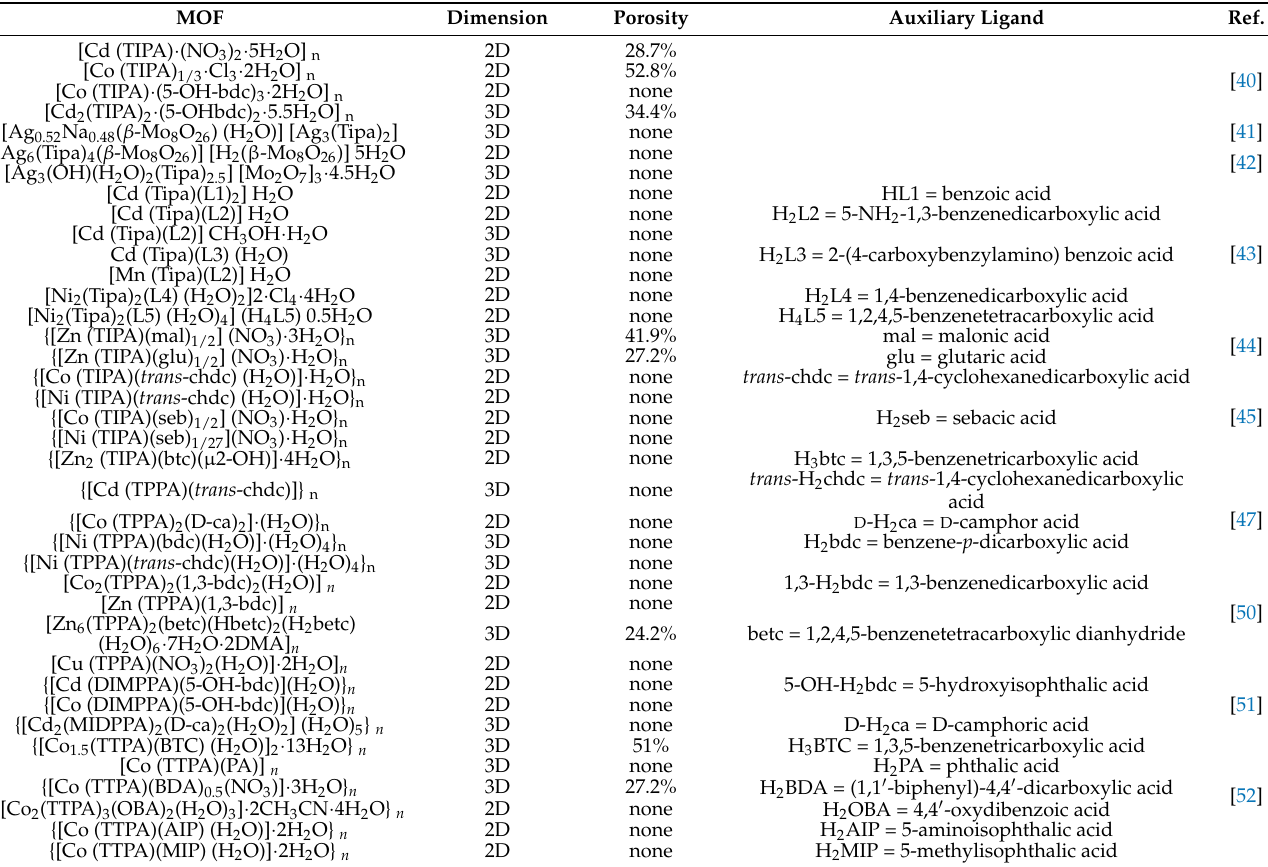
Table 1. Examples of MOFs based on